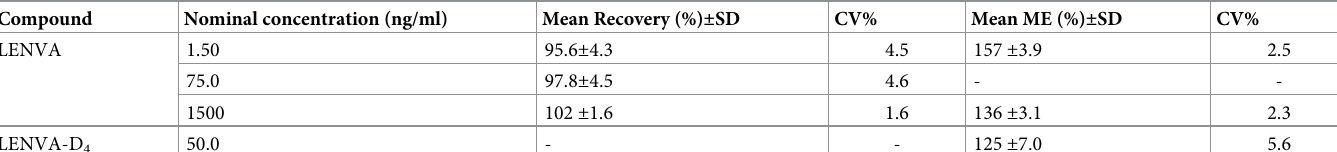
Table 3. Recovery and matrix effect (ME) results of LENVA and LENVA-D 4 in human plasma samples.